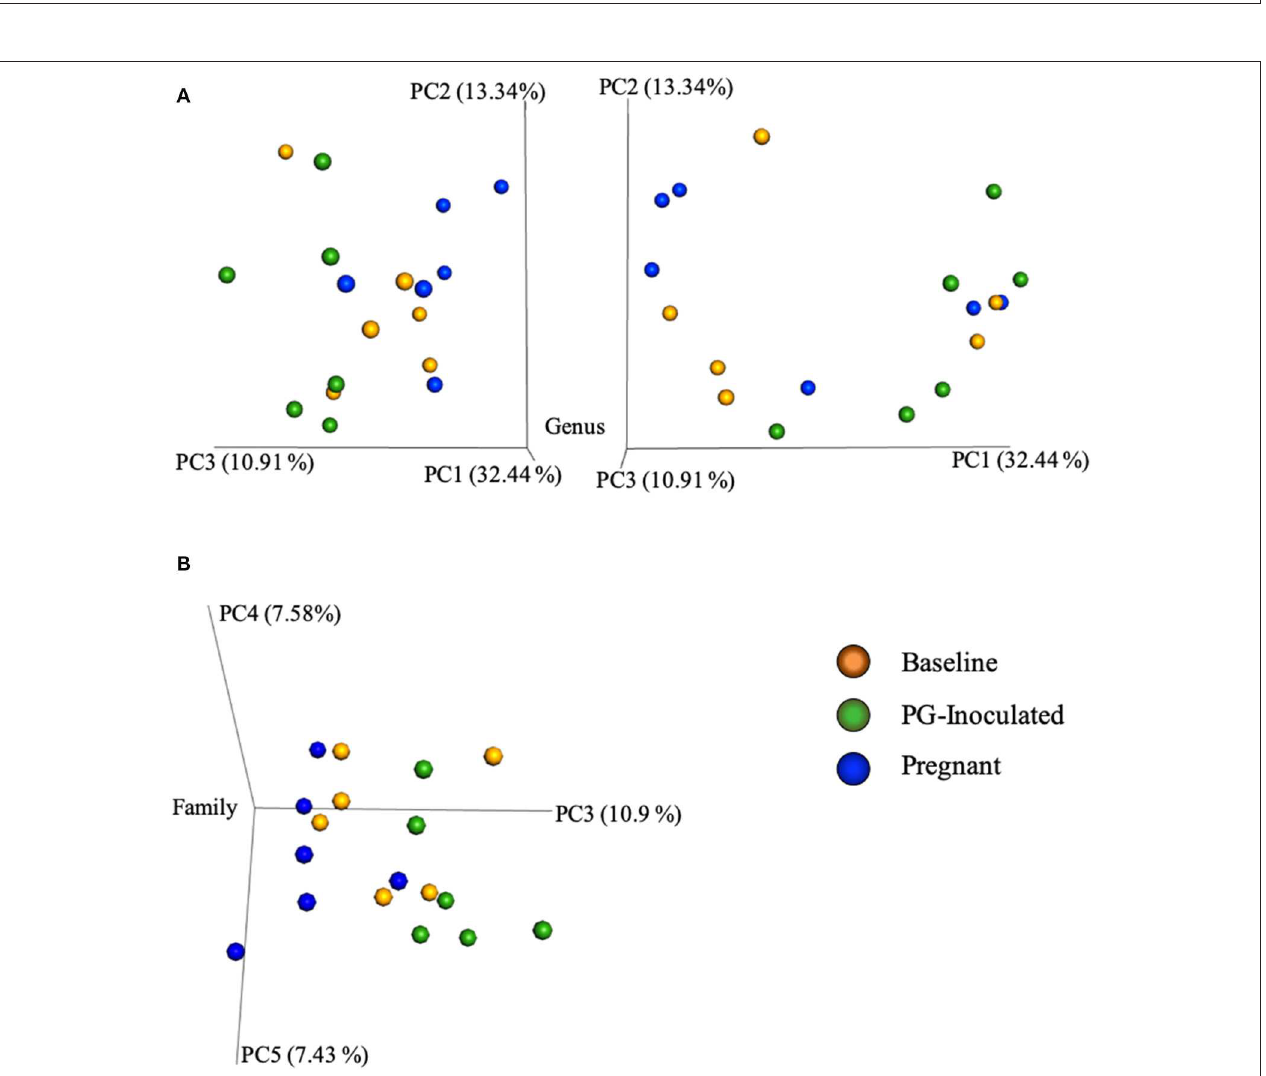
Frontiers in Cellular and Infection Microbiology |